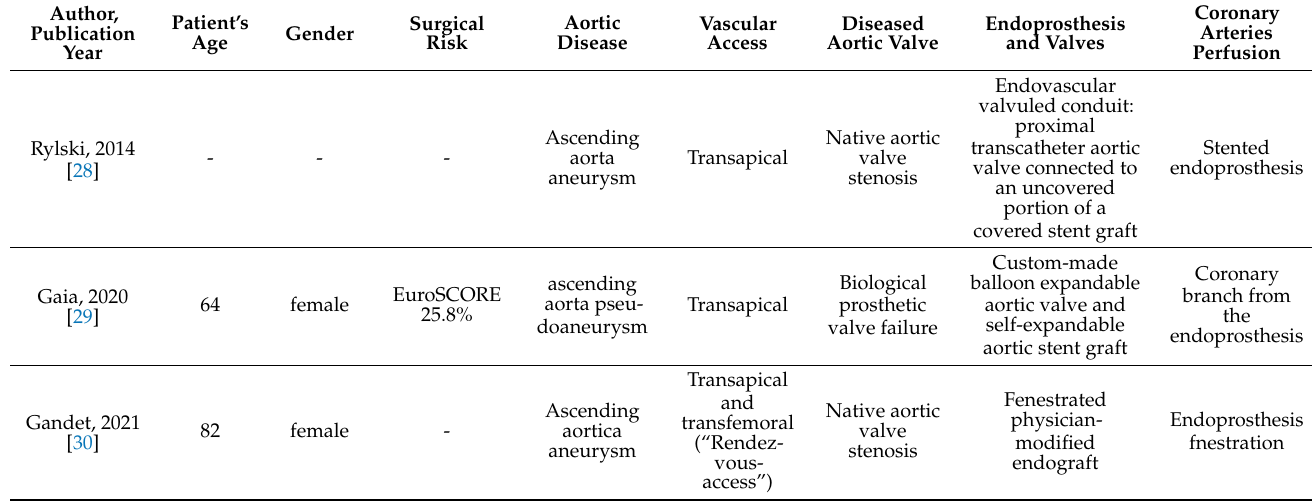
artery vein graft during ascending aorta stenting.